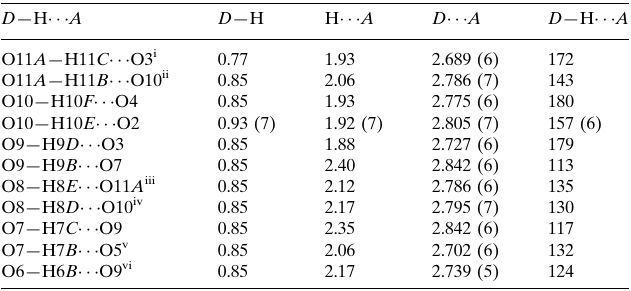
Hydrogen-bond geometry (A˚ , (cid:4)